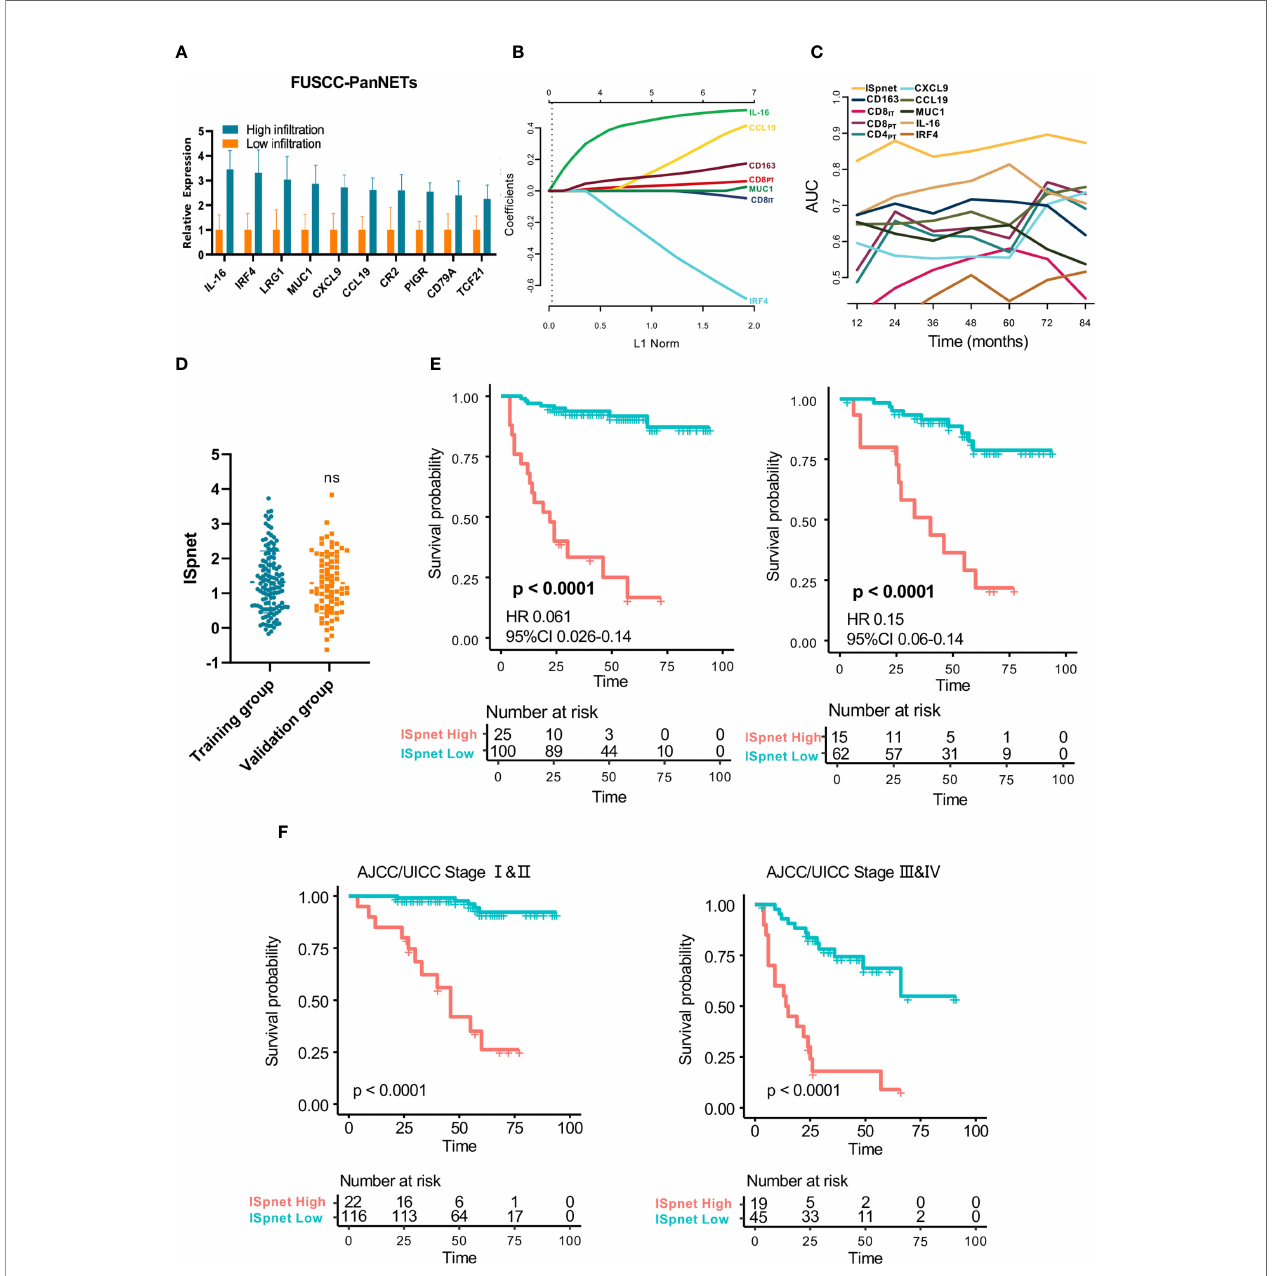
FIGURE 3 | Quantitative Immunoscore establishment and validation in patients with Pan-NETs. (A) Ten immune signatures with statistically signi fi cant expression differences selected by qPCR methods in 60 Pan-NET patients for further analysis. (B) Feature selection using the LASSO regression model. Coef fi cient pro fi le of the immune-related signatures associated with RFS of patients with Pan-NETs. (C) Time-dependent ROC curve describing the prognostic accuracy of the ISpnet and single immune features in the training cohort. (D) Kaplan-Meier curves for recurrence-free survival between the immune signature-de fi ned high-risk and low-risk groups in the training and validation cohorts. (E) Scatter diagram illustrating the ISpnet of the training and validation cohorts. (F) Survival probability of Pan-NET patients with different AJCC/UICC staging system staging in low- and high-ISpnet patients. Ns, No signi fi